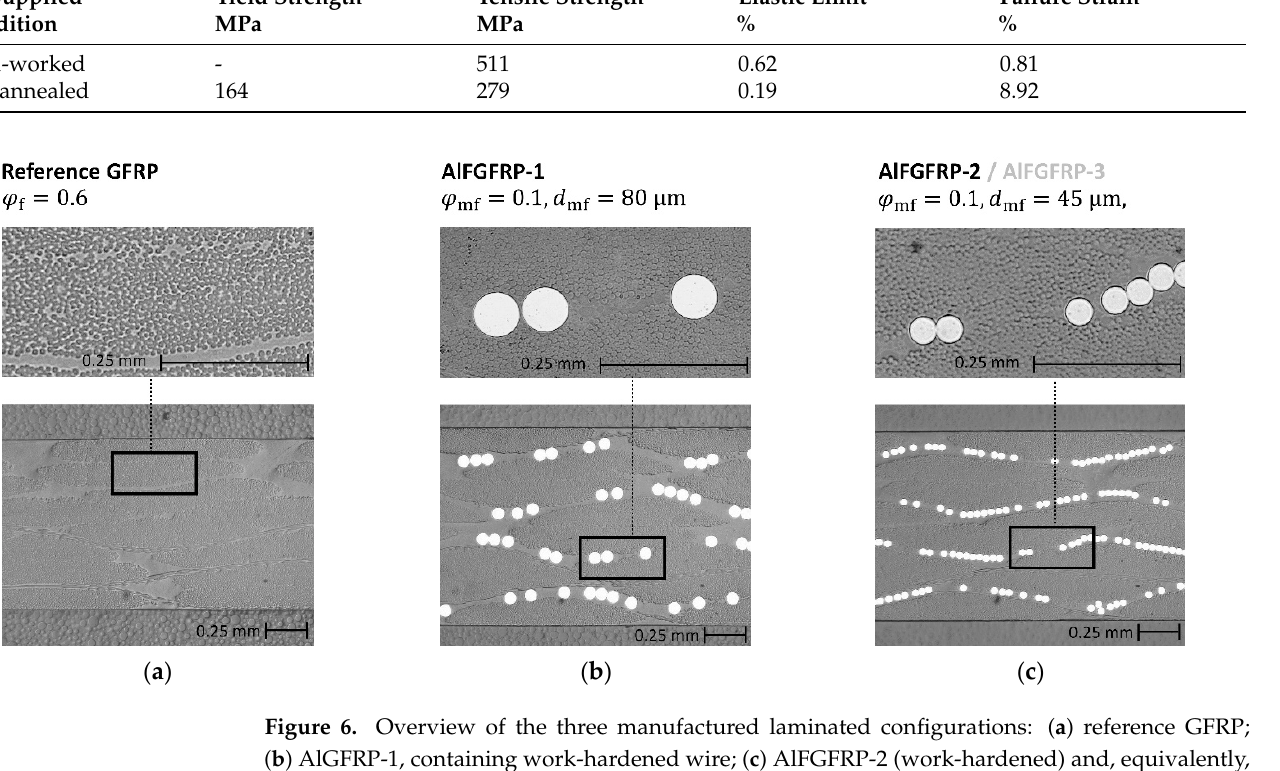
( c ) Figure 7. Overview of the test specimens (all dimensions in mm): ( a ) transverse tension; ( b ) longi- tudinal tension, ( c ) longitudinal tension with electrical contacts.